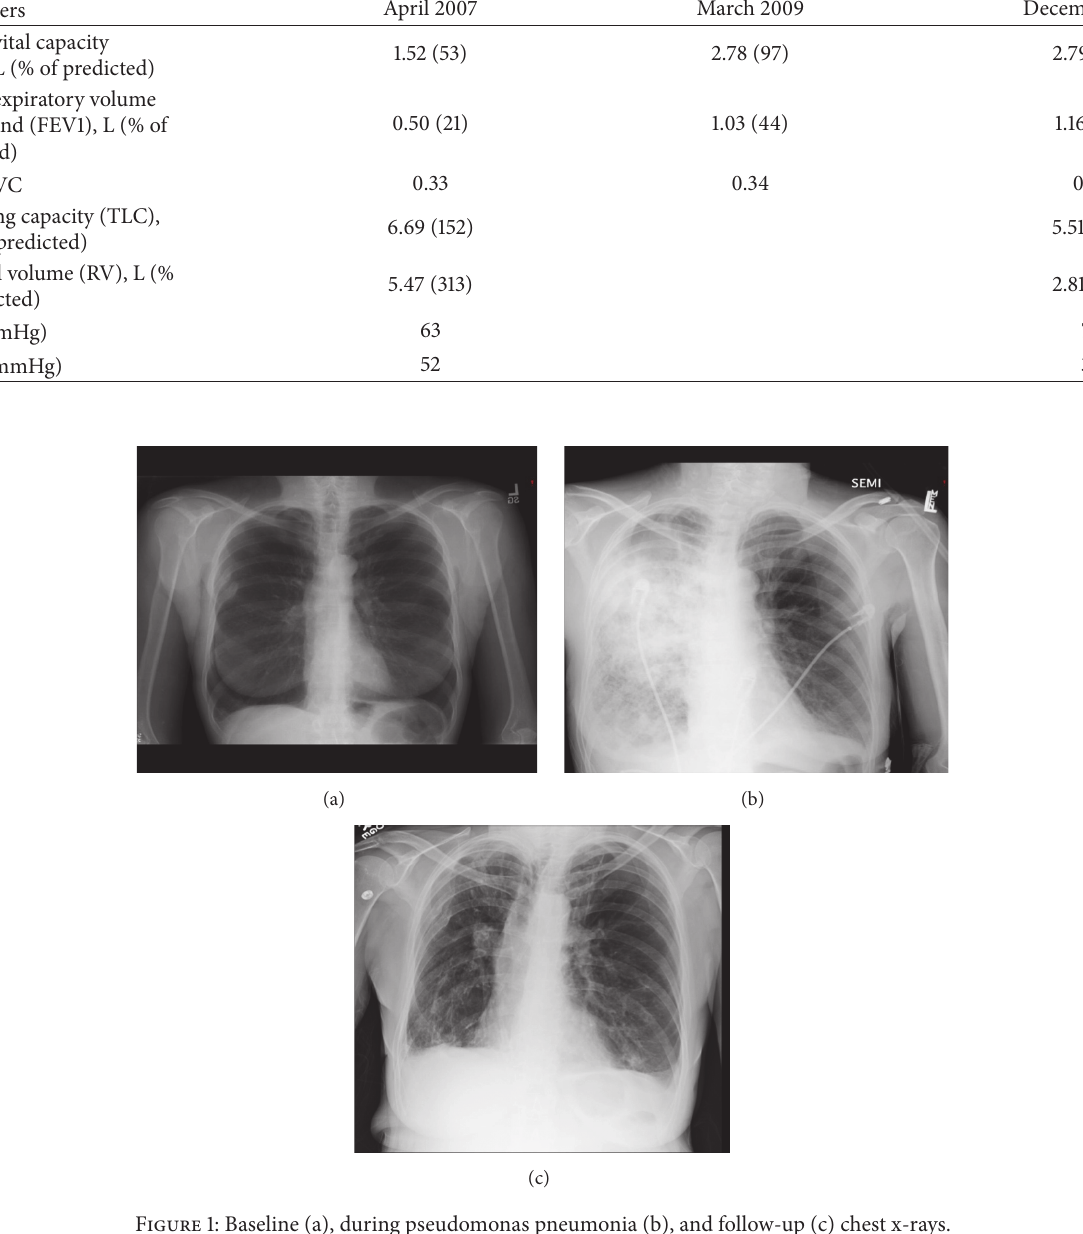
Figure 1: Baseline (a), during pseudomonas pneumonia (b), and follow-up (c) chest